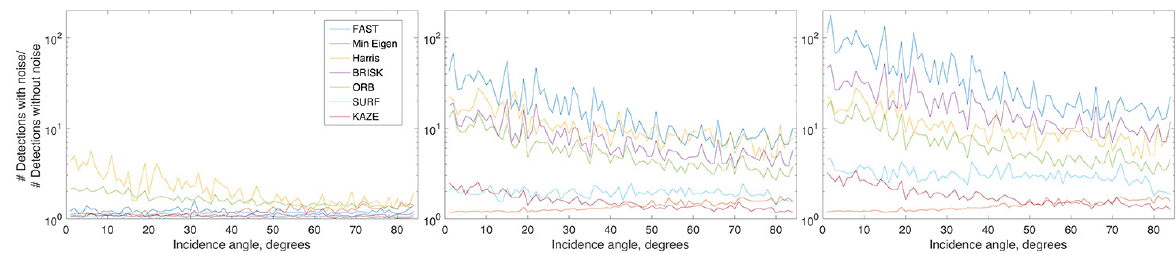
Figure 6. Increase in the number of false feature detections when Gaussian noise is applied to image with a mean of zero and a variance of 0.001 (Left), 0.011 (middle) and 0.021 (right).